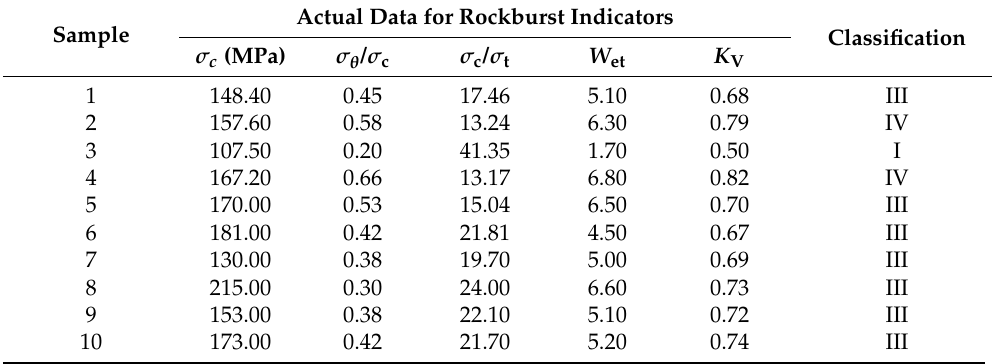
Table 3. Indicators and classes of actual rockburst intensity.